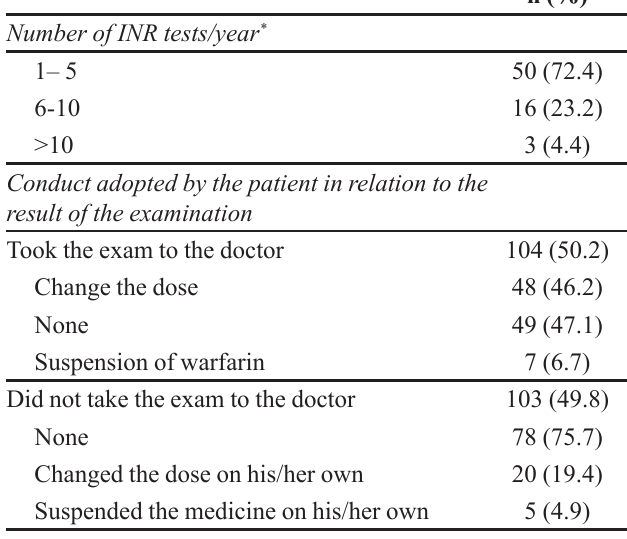
FIGURE 2. Itinerary of patients for the resolution of bleending and thrombosis, according to the warfarin considering the level of attention in cohort monitoring in the city of Ijuí/RS. n = TABLE II - Frequency of examination and conduct in relation to the result of the INR, in the municipality cohort of Ijuí/RS n= 69 n (%)